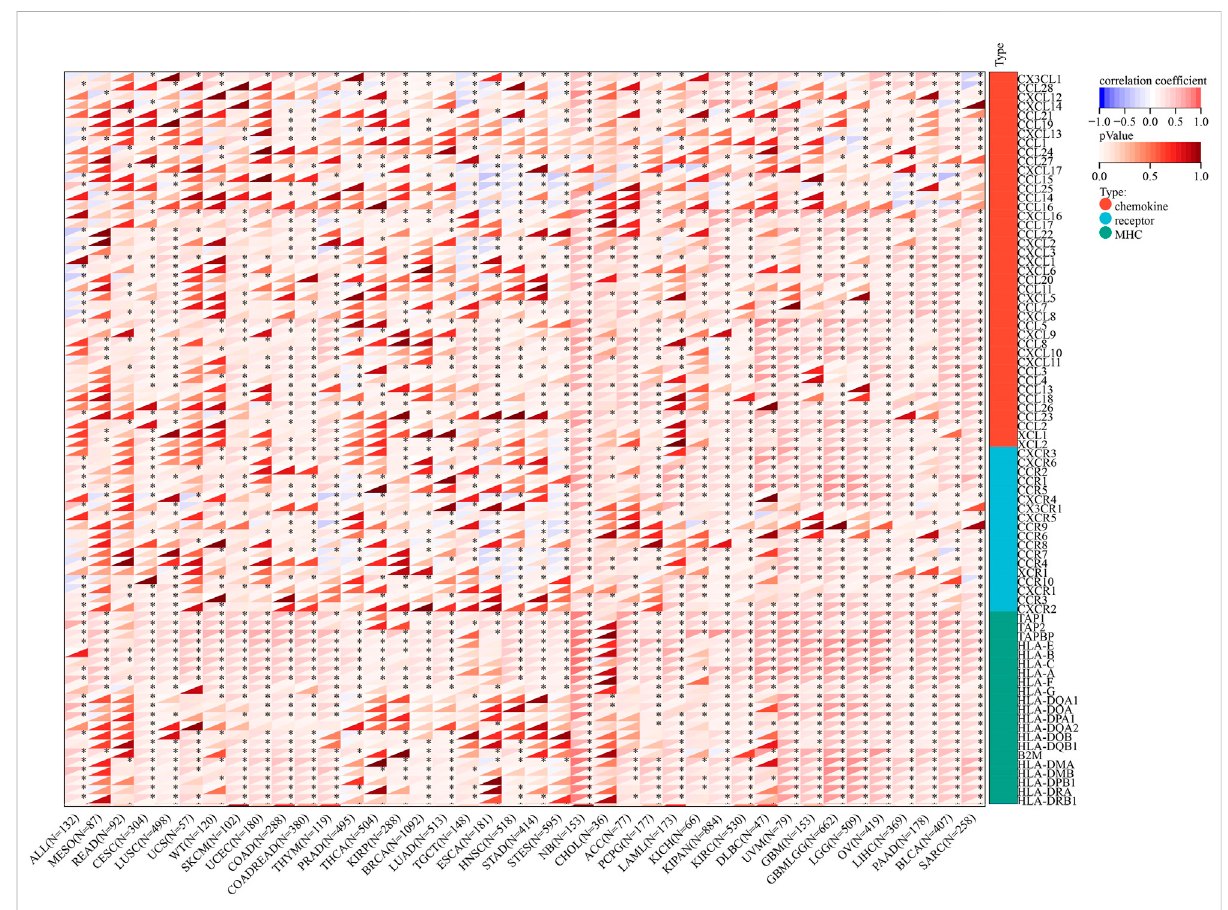
FIGURE 12 Analysis of correlation between the expression of AGTRAP and immunoregulatory